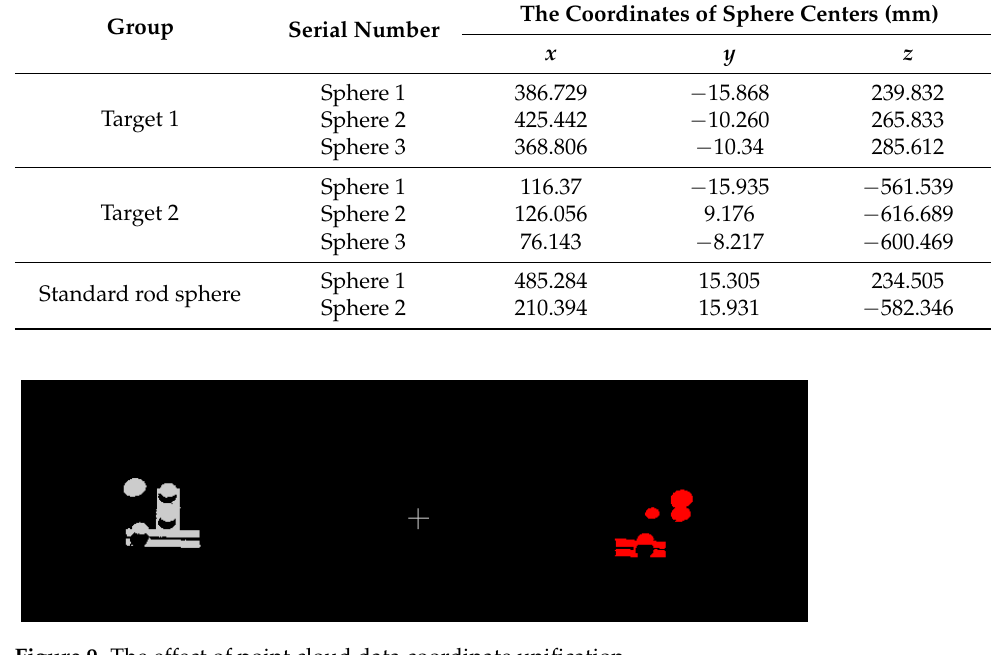
Figure 9. The effect of point cloud data coordinate unification.